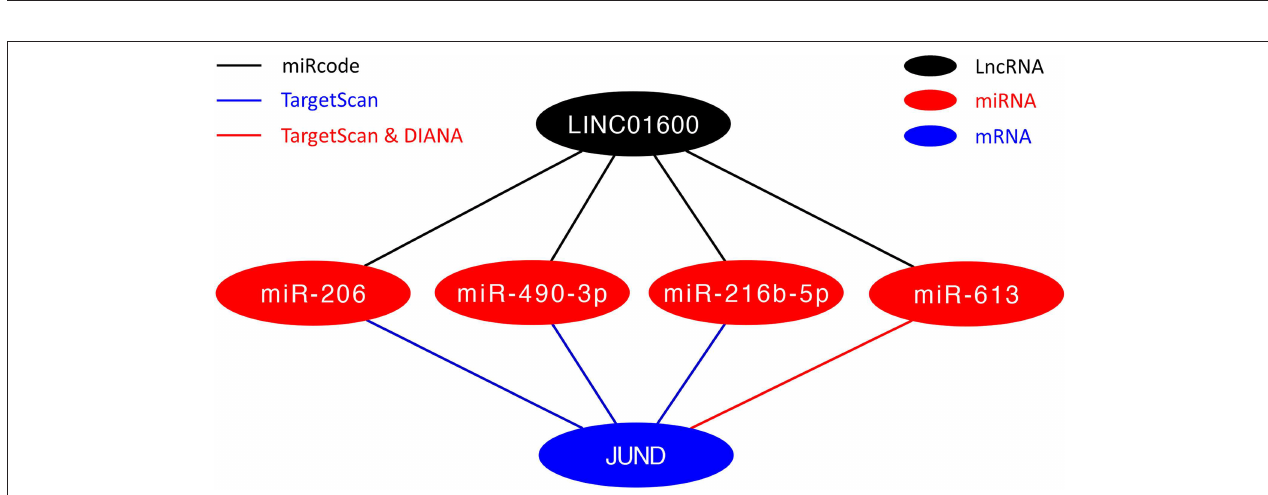
FIGURE 8 | The ceRNA network of LINC01600—miRNAs—JUND.